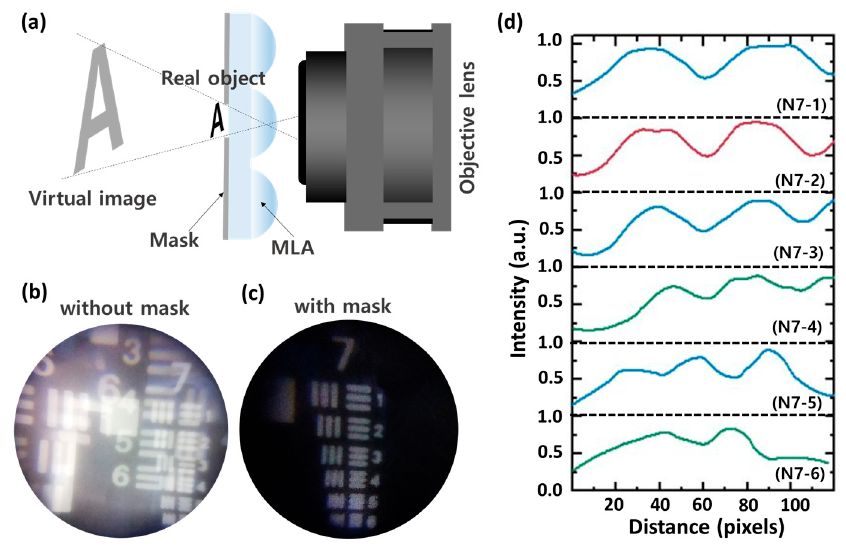
Figure 8. MLA-assisted higher magnification imaging. ( a ) A schematic illustration for imaging principle of MLA-based higher magnification imaging. Captured microscopic images from the MLA-assisted MCM ( b ) without a mask ( c ) with a mask. ( d ) The corresponding normalized intensity profiles of captured the image of group 7 on the USAF 1951 target through the MLA-assisted MCM. A scratch pattern with a dimension of 1 × 16 µ m (Scratch & Dig Target, ISO 10110, Grade# 0.004) was observed through the MLA-based MCM, as shown in Figure 9. The MLA-based MCM observes a clear pattern compared with the digital zoom image of MCM, which offers a blur edge pattern due to the artificially ‐ enlarged pixels. The magni ‐ fication of MLA ‐ assisted MCM is 8.43×, which is 3.92 times higher than that of MCM.